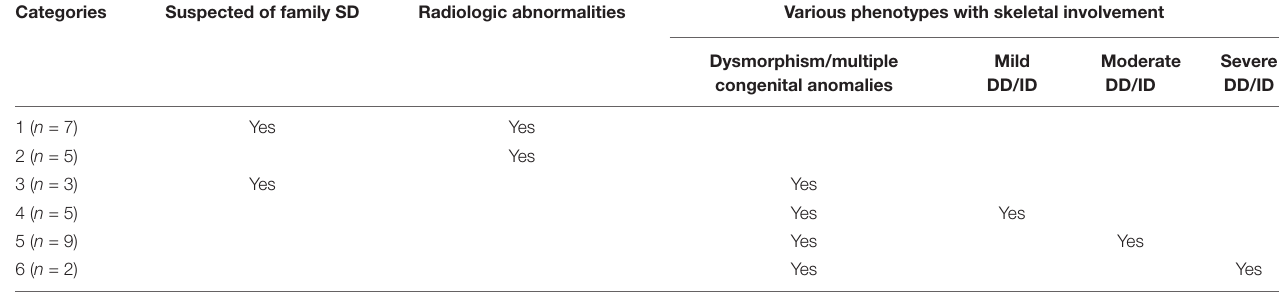
TABLE 1 | Categories of the